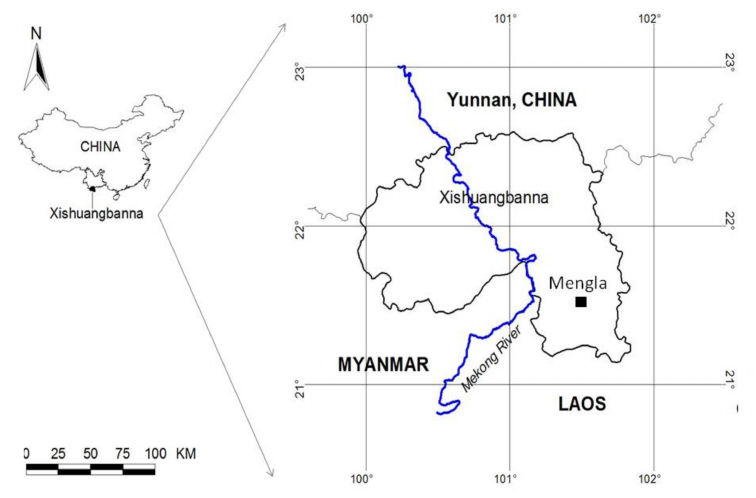
Figure 1. Study site